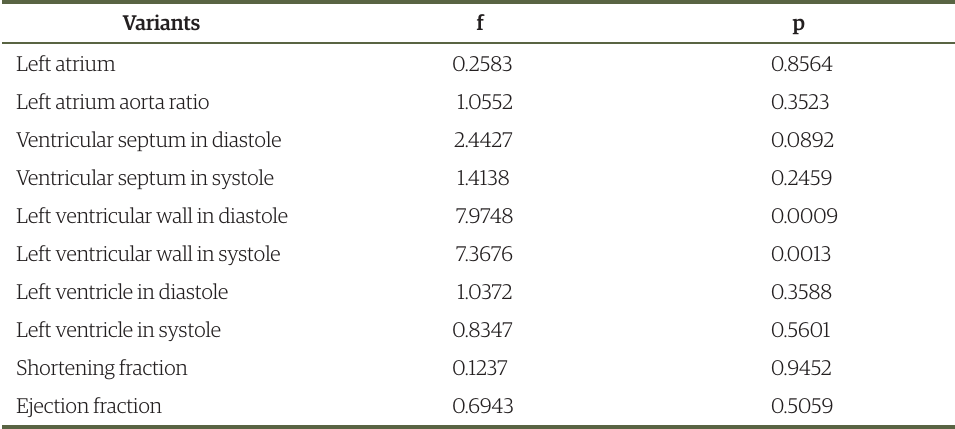
Table 1. Analysis of variance of the echocardiography measurements with significance levels (p).